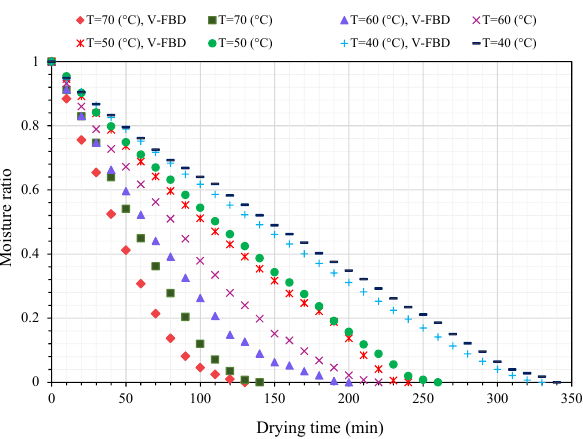
Fig. 5. Moisture ratio versus drying time of hawthorn at different drying air temperatures (drying air flow rate=26 m 3 /h and vibration intensity=7.5 Hz in vibro mode)